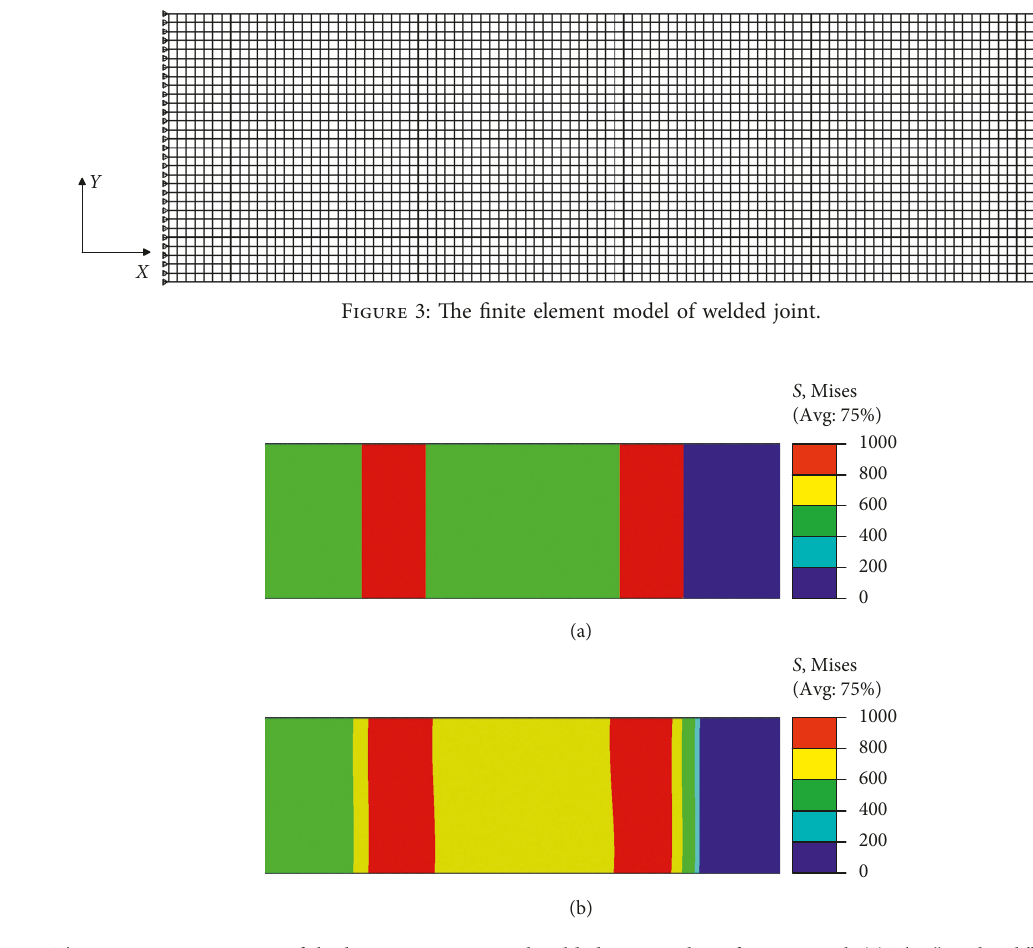
Figure 4: The Mises stress contour of the heterogeneous metal welded joint at the safety terminal. (a) The “sandwich” material structure model. (b) Continuous transition material structure model.